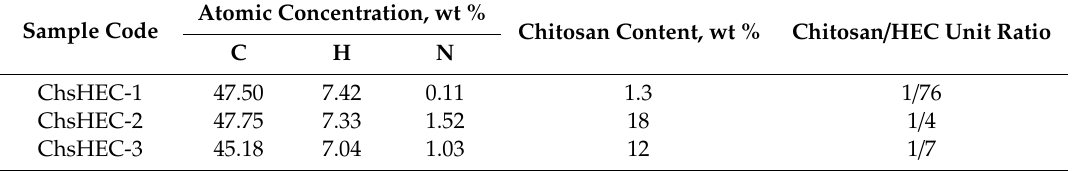
Table 2. Elemental analysis data of water-soluble at neutral pH fractions and the calculated chitosan content.